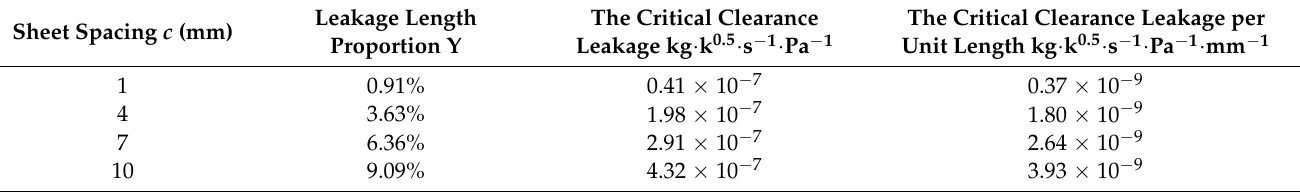
Table 6. The critical equivalent mass flow of clearance leakage ( a = 1.0